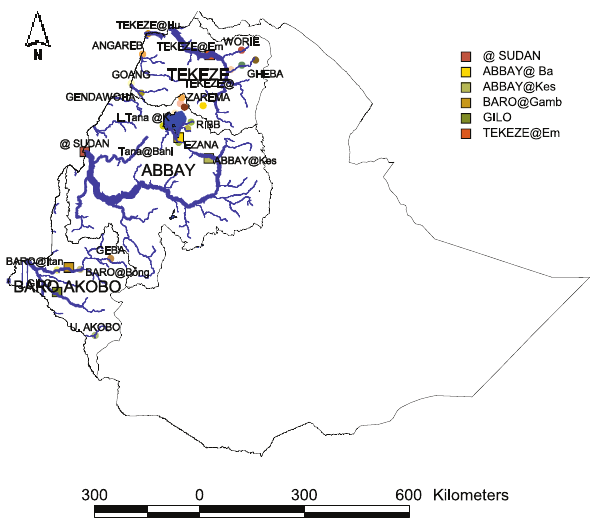
Fig. 1. Map showing an outline of Ethiopia and the water sources of Figure 1: map showing an outline of Ethiopia and the water sources of Eastern Nile basin Eastern Nile basin including stream gauges at the major tributaries including stream gauges at the major tributaries (dots) and stream gauges for calibration and (dots) and stream gauges for calibration and validation of the model validation of the model (boxes). (boxes).